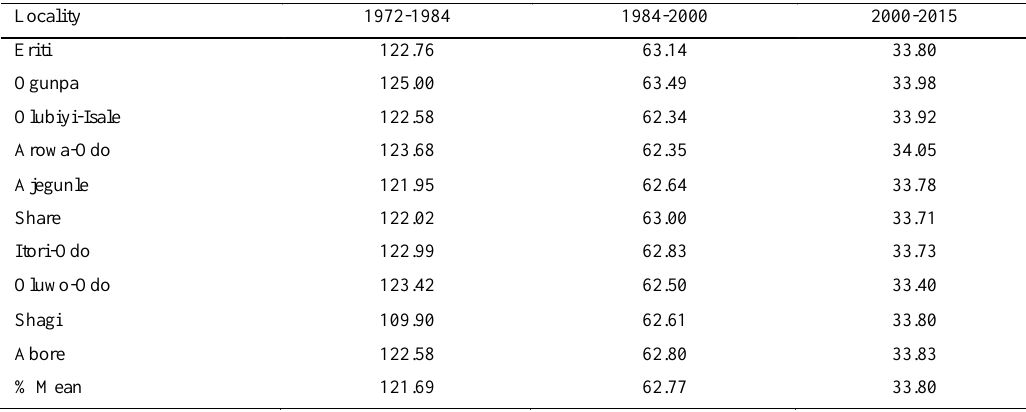
Table 4: Percentage increase in population within the period among the localities (Adeleke,